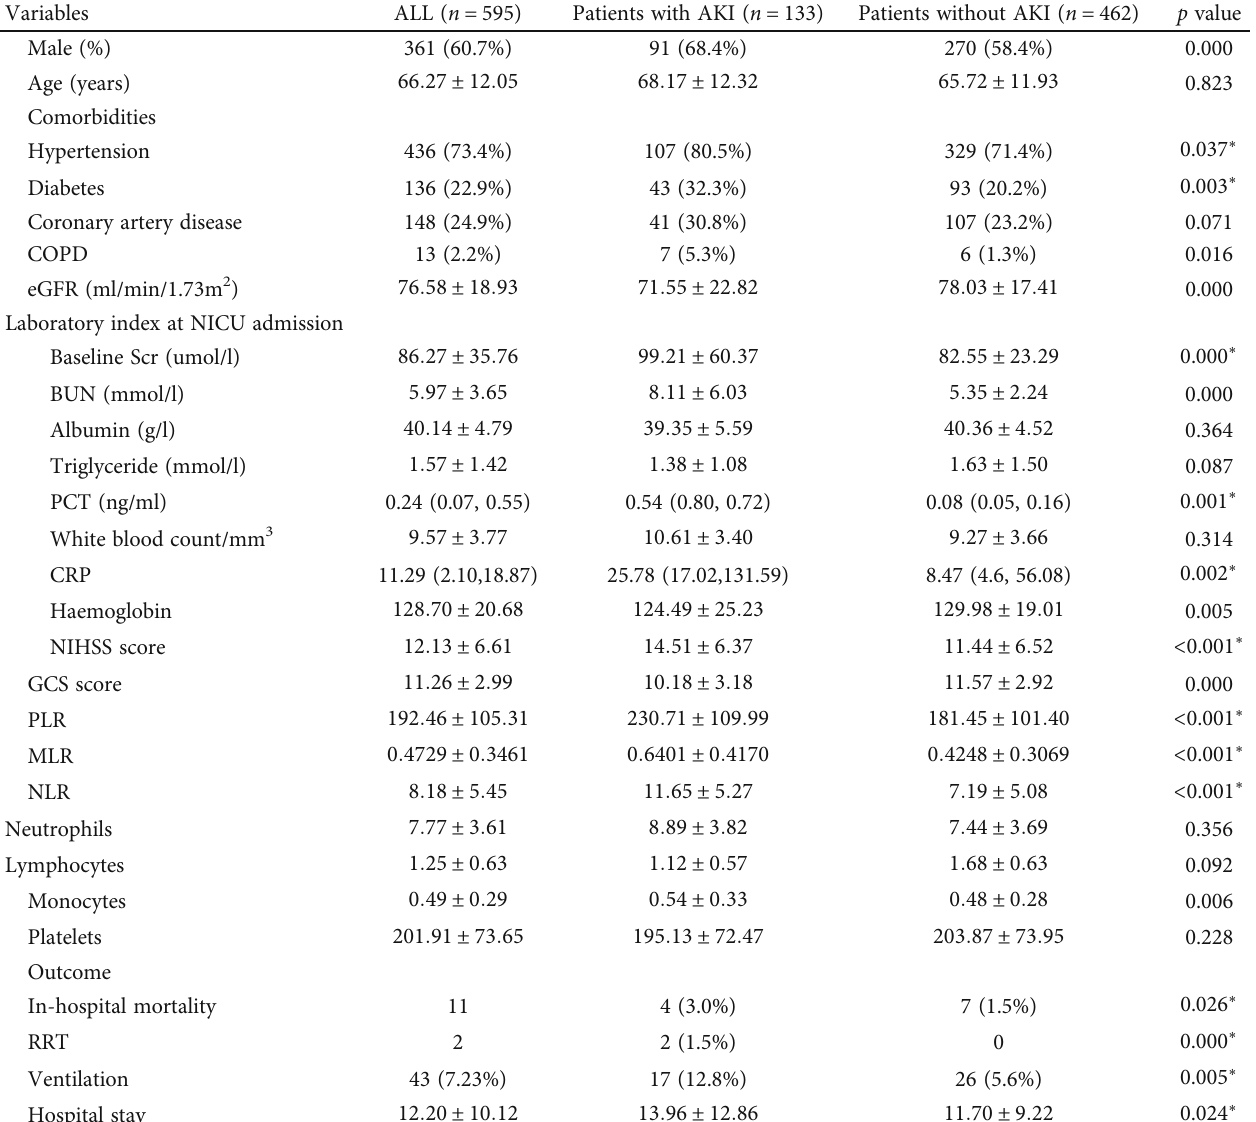
Table 1: Subjects ’ initial features and